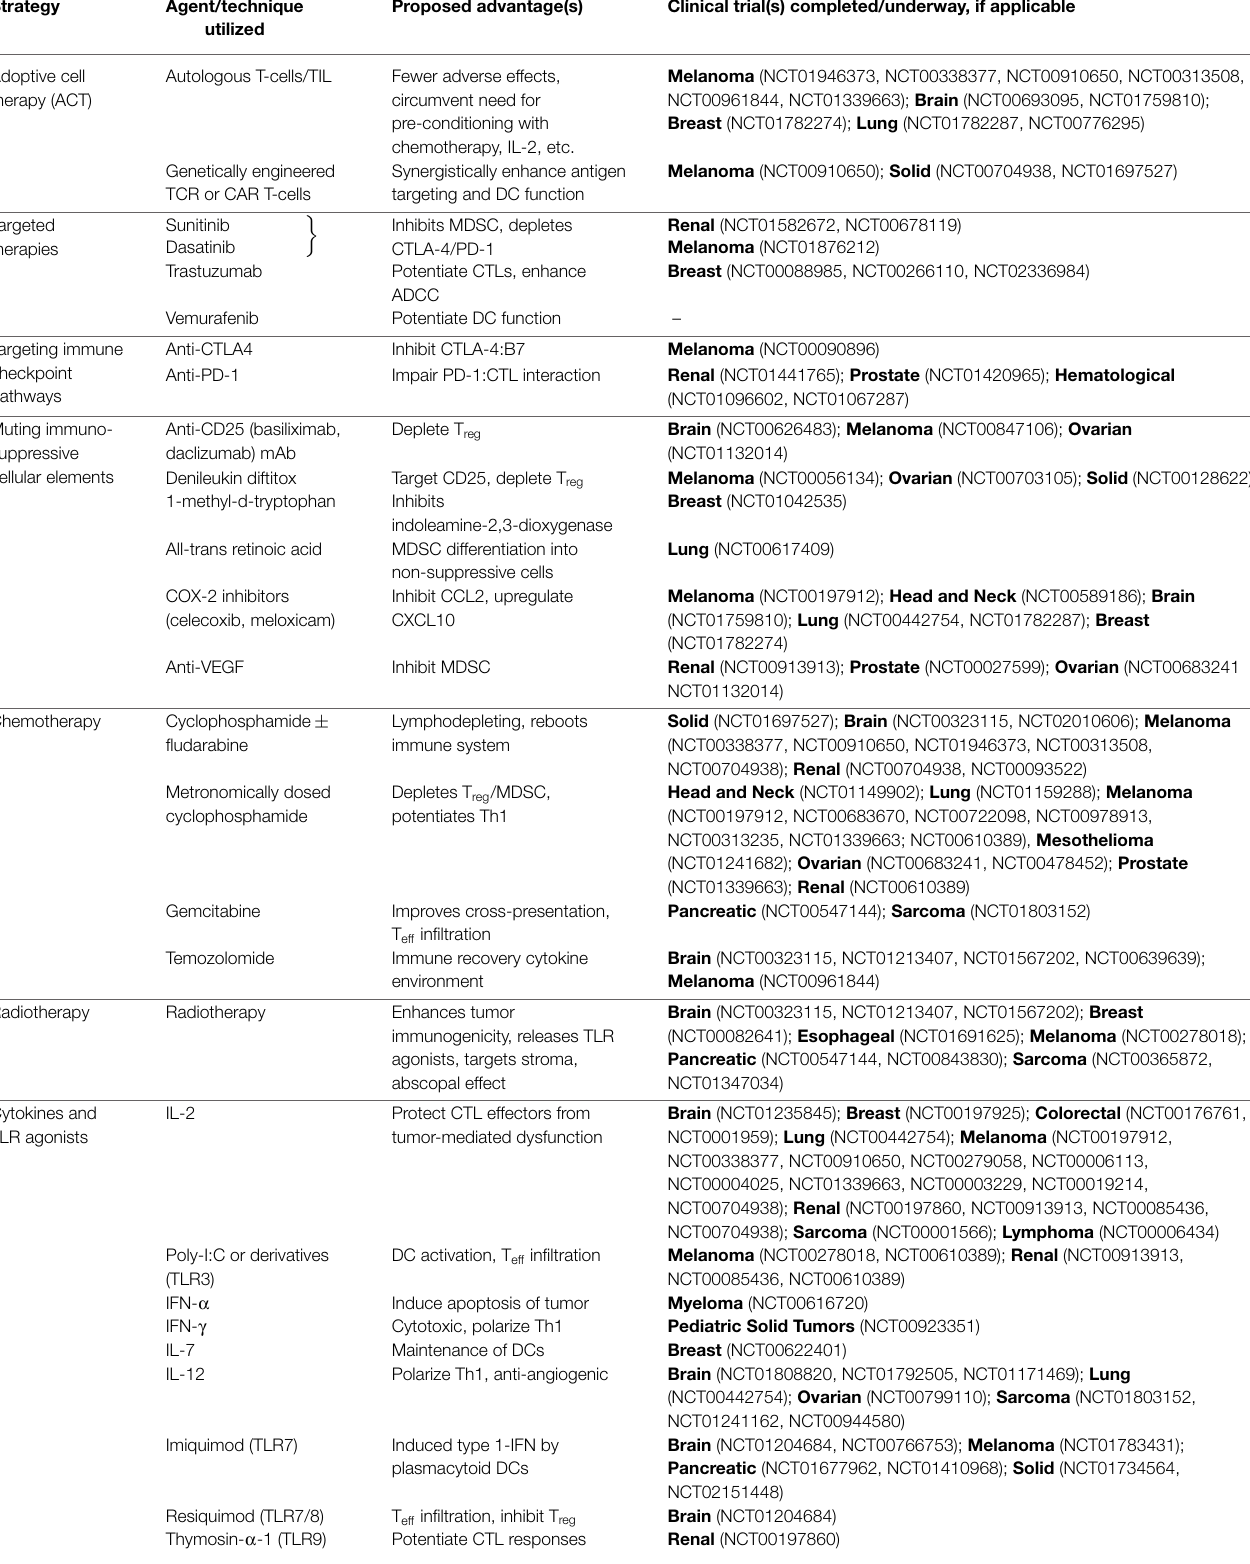
TABLE 1 | Multimodality strategy to enhance the efficacy of dendritic cell-based vaccination .